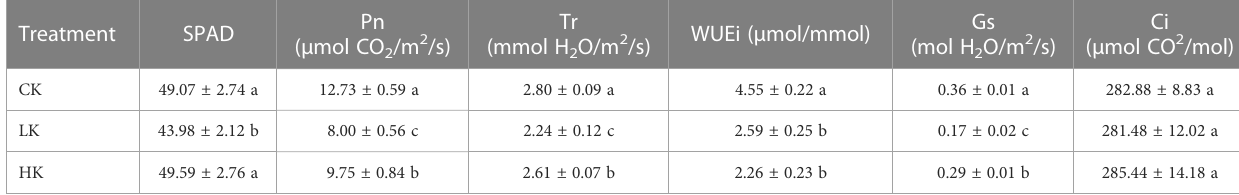
Data indicate means ± SE ( n = 3). Different letters beside the values in the same column indicate signi fi cant difference between the